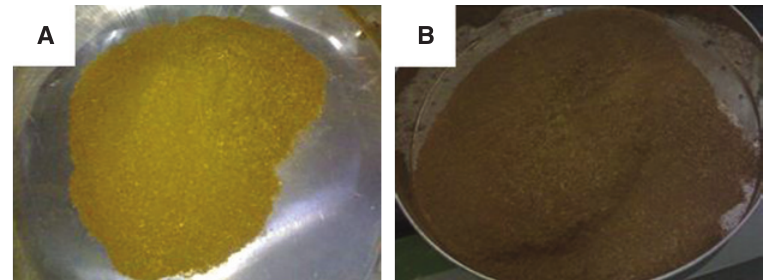
Figure 1 Municipal solid waste: (A) raw and (B)